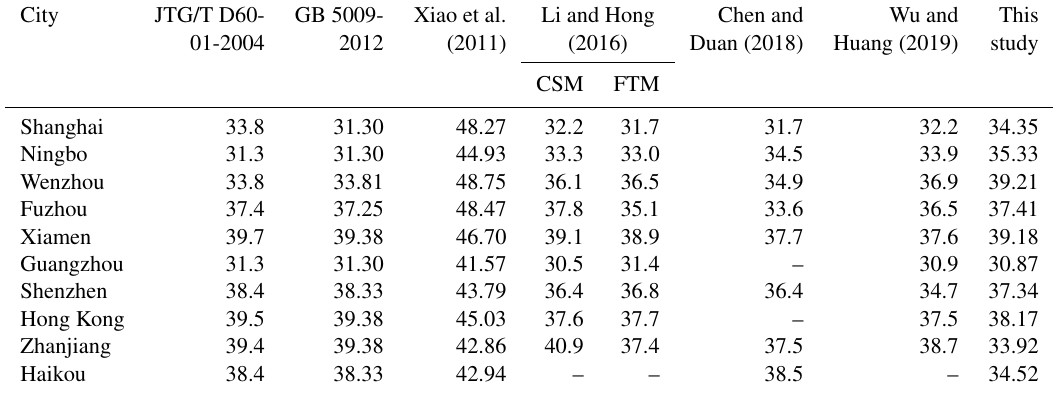
Table 4. Comparison of TC design wind speed at selected cities (MRI = 100 years; T = 10min; z = 10m, z 0 = 0 . 05m; ms − 1 ).